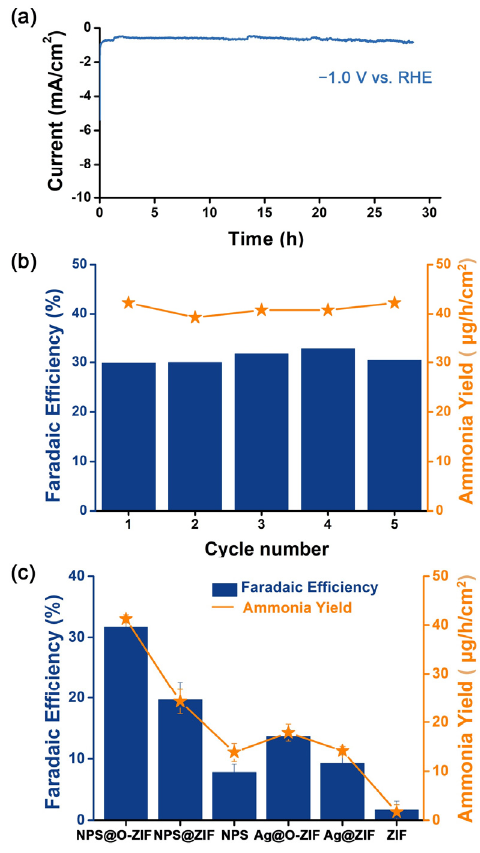
Figure 4. ( a ) Stability of NPS@O-ZIF for 30 h ENRR test. ( b ) Cycling tests for five consecutive ENRR under − 1.0 V vs. RHE. ( c ) Comparison of ENRR performance using various electrocatalysts.